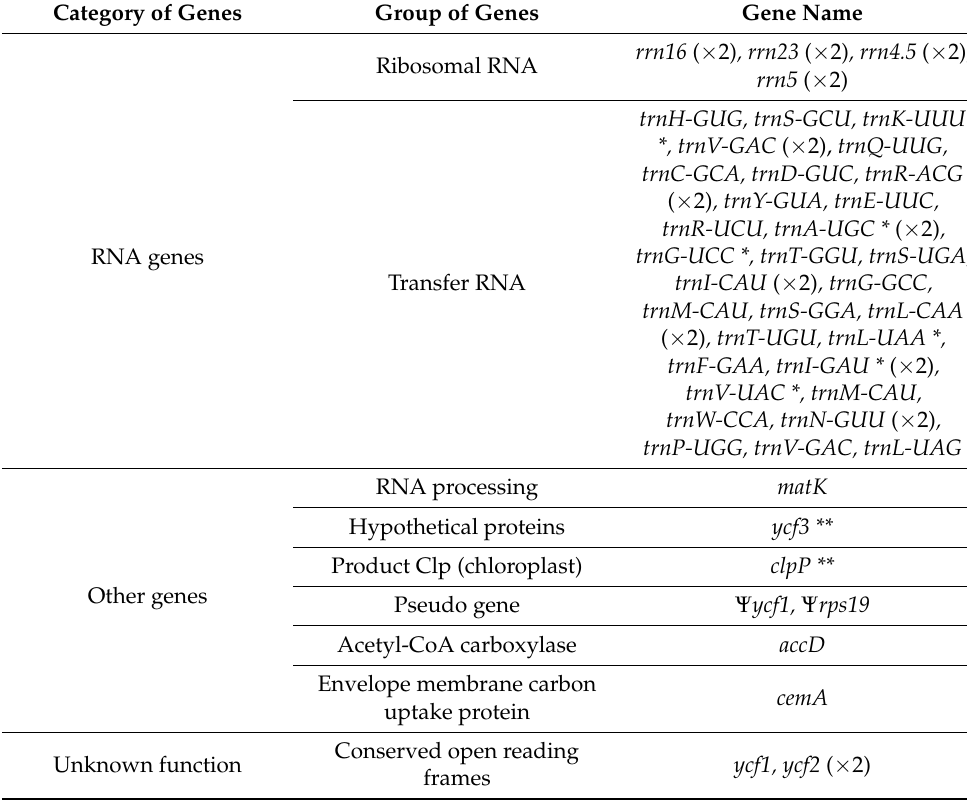
Table 2. Cont . Category of Genes Group of Genes Gene Name Ribosomal